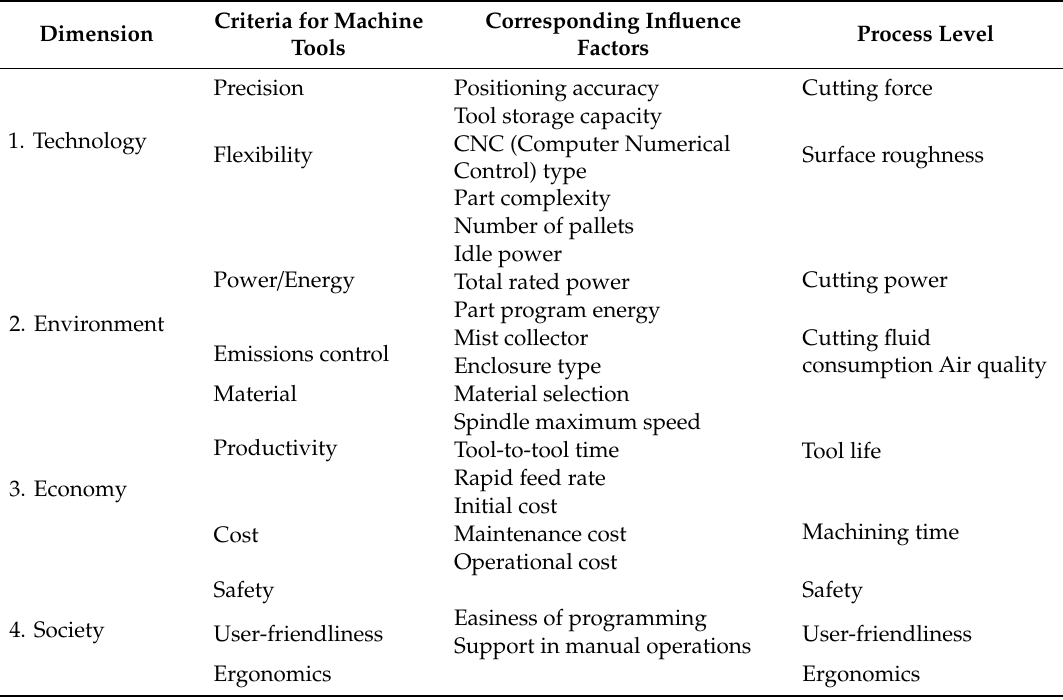
Table 1. The dimensions of sustainable machine